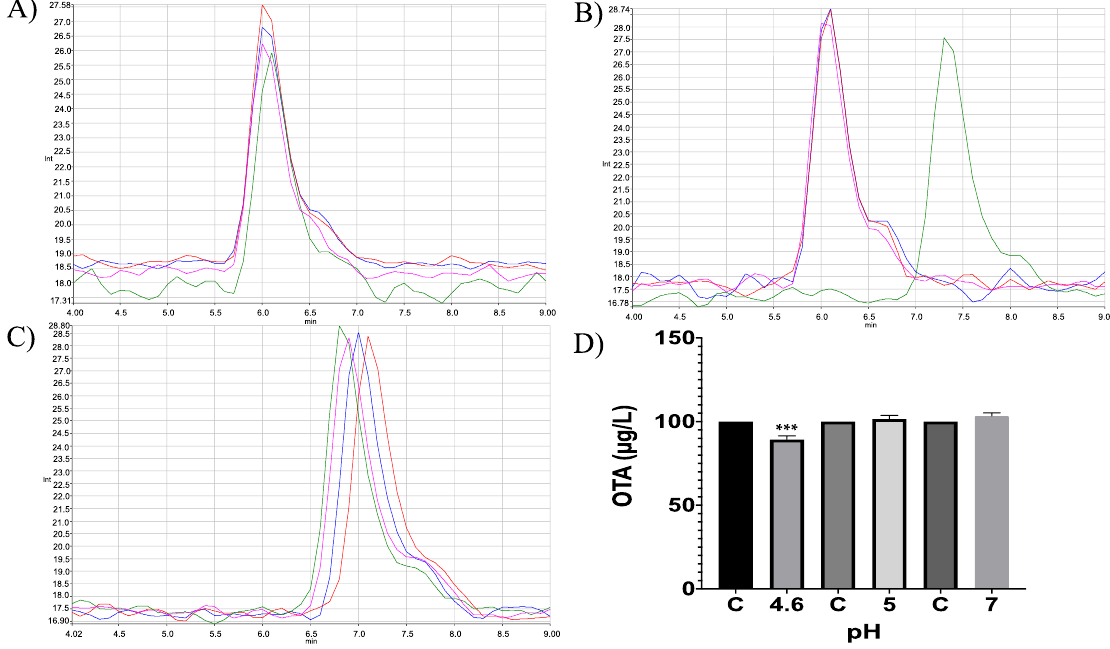
Figure 17. Trypsin in vitro experiments. HPLC-fluorescence chromatograms of trypsin–OTA in vitro assays showed differences in trypsin’s ability to degrade OTA at different pH conditions and incubated at 41 °C. ( A ) pH 4.6; ( B ). pH 5; ( C ) pH 7; ( D ) Bars show OTA (µg/L) degradation (10.69%) by trypsin at pH 4.6. In all chromatograms, the control is represented in red and experimental repetitions are in blue, green and pink. (*** p < 0.0001).